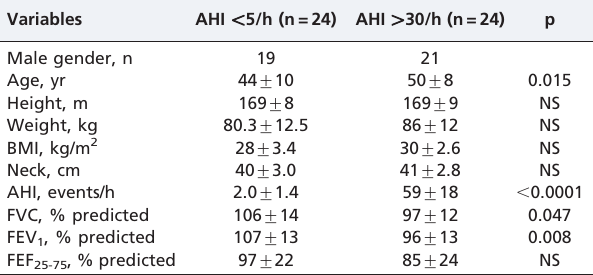
Table 1 – Subject anthropometric and respiratory data according to apnea hypopnea index.